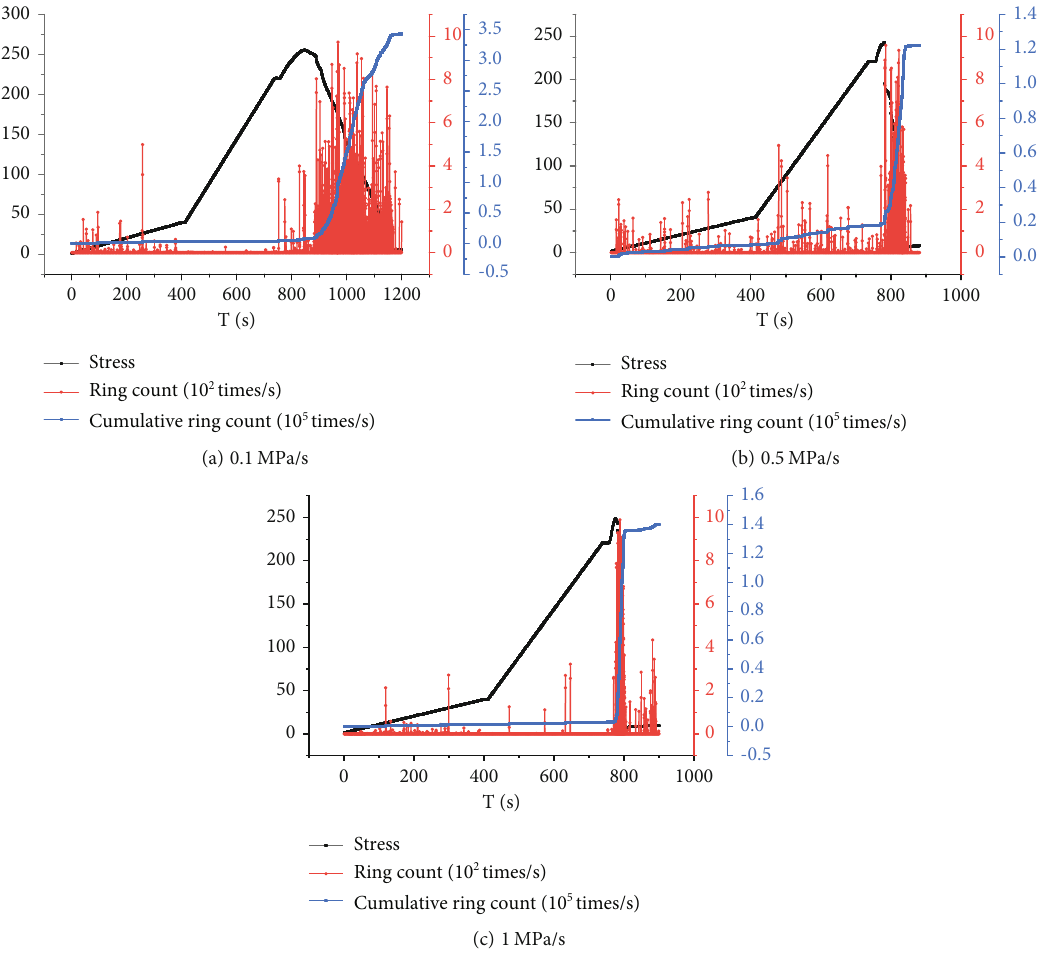
Figure 3: Limestone stress-(cumulative) acoustic emission ringing count-time relationship curve at the same con fi ning pressure with di ff erent unloading rates. Note: in the fi gure, the black vertical coordinate on the left side represents the stress magnitude during the loading of the limestone, the red vertical coordinate on the right side represents the acoustic emission ringing counts during the loading of the limestone, and the blue coordinate represents the cumulative ringing